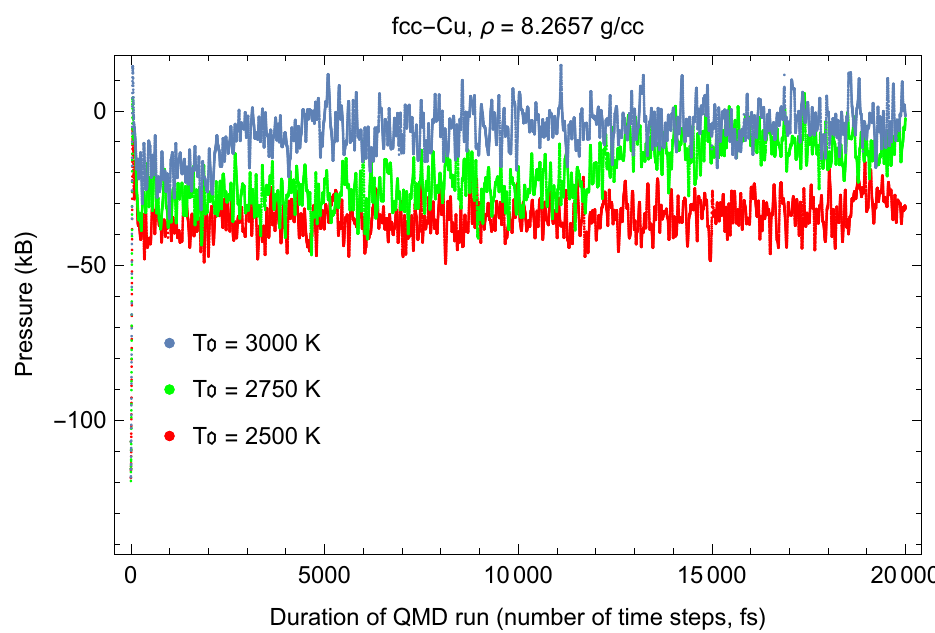
Figure 2. The same as in Figure 1 for melting P